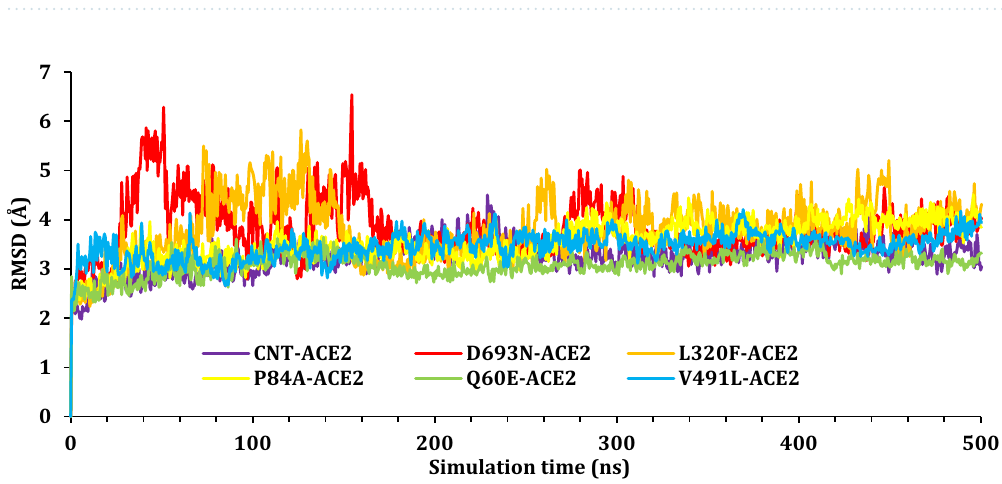
Figure 8. The RMSD for Cα atoms (Å) with respect to the initial structure as a function of simulation time (ns) for the ACE2